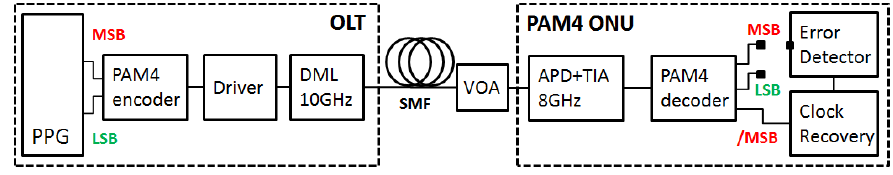
Figure 1. Original experimental setup.